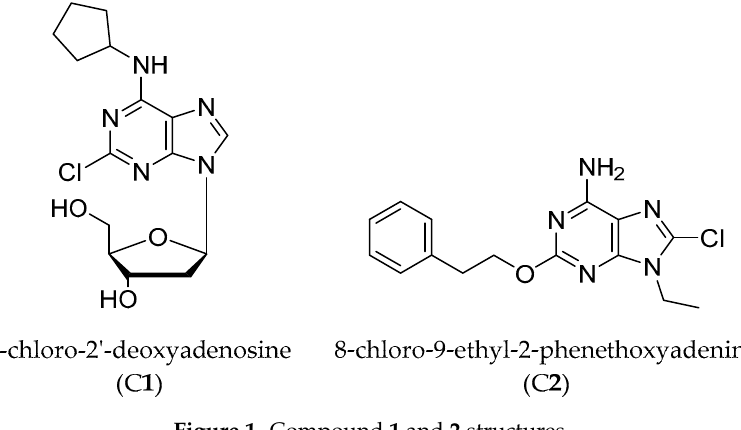
Figure 1. Compound 1 and 2